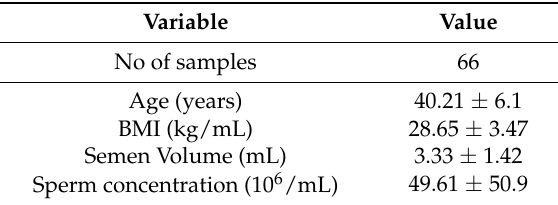
Table 1. Demographic data (mean ± SD) of all men studied.